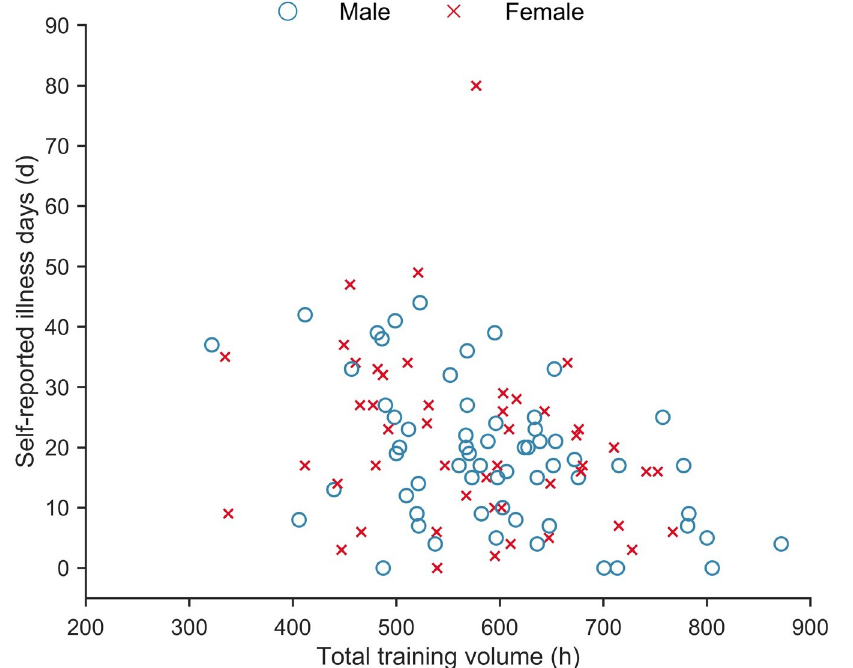
Fig 5. Association between self-reported illness days and total annual training